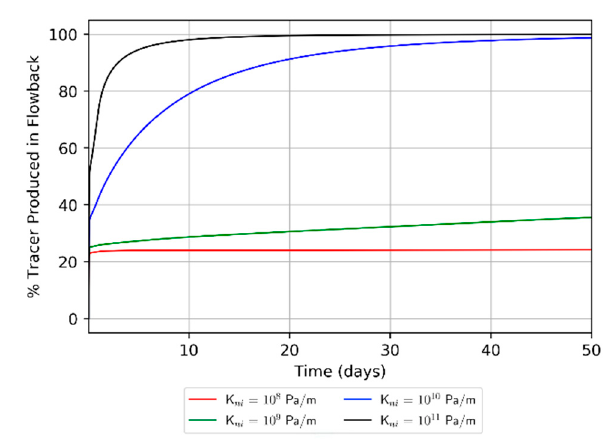
Figure 11. Impact of fracture stiffness (rate of fracture closure) on the tracer response curve.